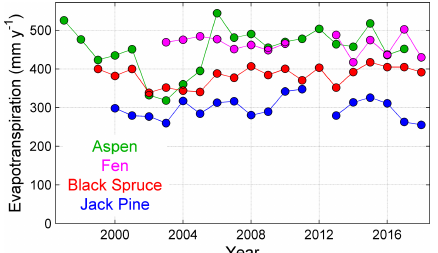
Figure 3. Annual ET (with energy-balance-closure adjustments) at the four BERMS sites from 1997 to 2018 showing generally higher values for the Old Aspen site than for the two conifer sites. The dry conifer site (Old Jack Pine) generally had lower ET than the wet conifer site (Old Black Spruce). The Fen had values exceeding the Old Aspen site following the 2001–2003 drought, with similar values in other